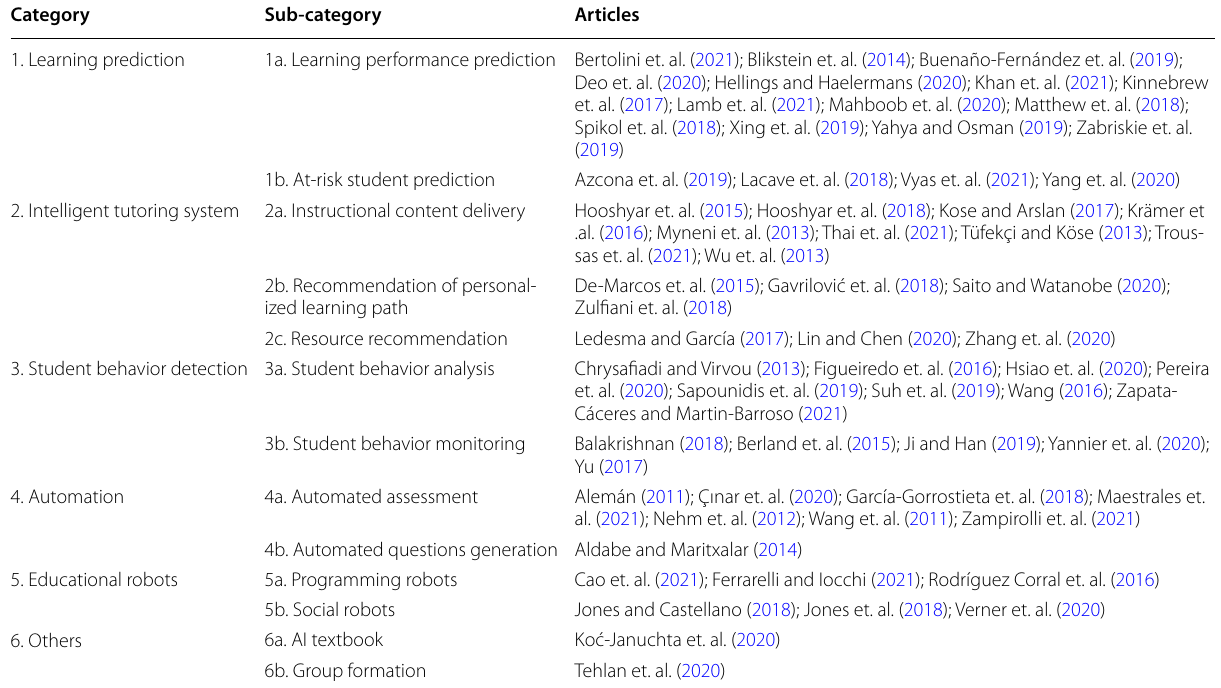
Table 3 The categories of AI applications in STEM education